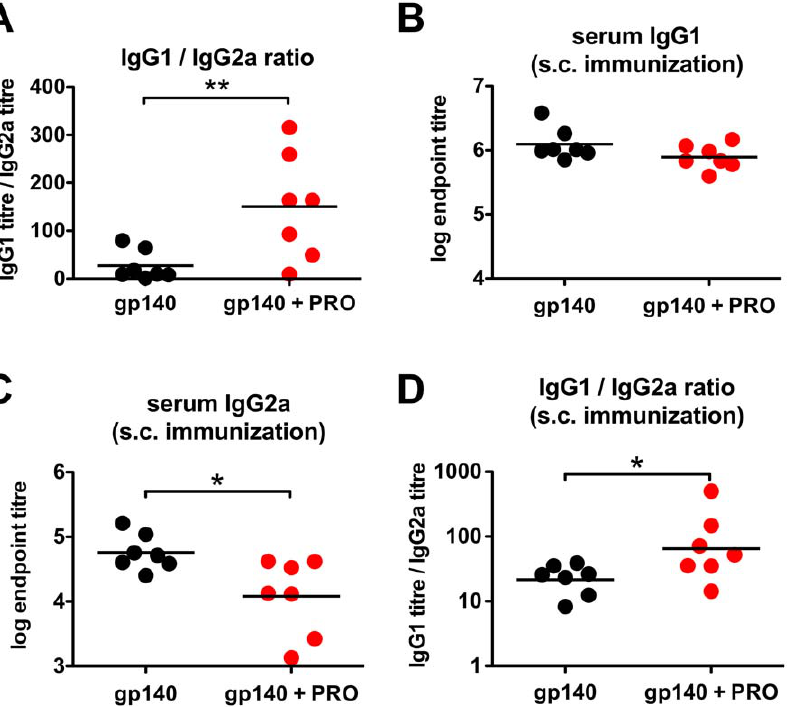
Figure 4. Influence of PRO 2000 co-administration on the type of T helper cell response. The serum specific IgG1- and IgG2a titres were determined as indicators of a Th2 or Th1 type of response, respectively. ( A ) Serum IgG1/IgG2a endpoint titre ratios of vaginally immunized mice (described in Figure 3A–C). ( B–D ) BALB/c mice (n=7) were primed s.c. with gp140 + / 2 PRO 2000 in FCA and were boosted using the same route and formulation without FCA. ( B ) Serum IgG1 endpoint titres; ( C ) IgG2a endpoint titres; ( D ) IgG1/IgG2a endpoint titre ratio. gp + PRO , combination of gp140 and PRO 2000. * p , 0.05; ** p , 0.01.